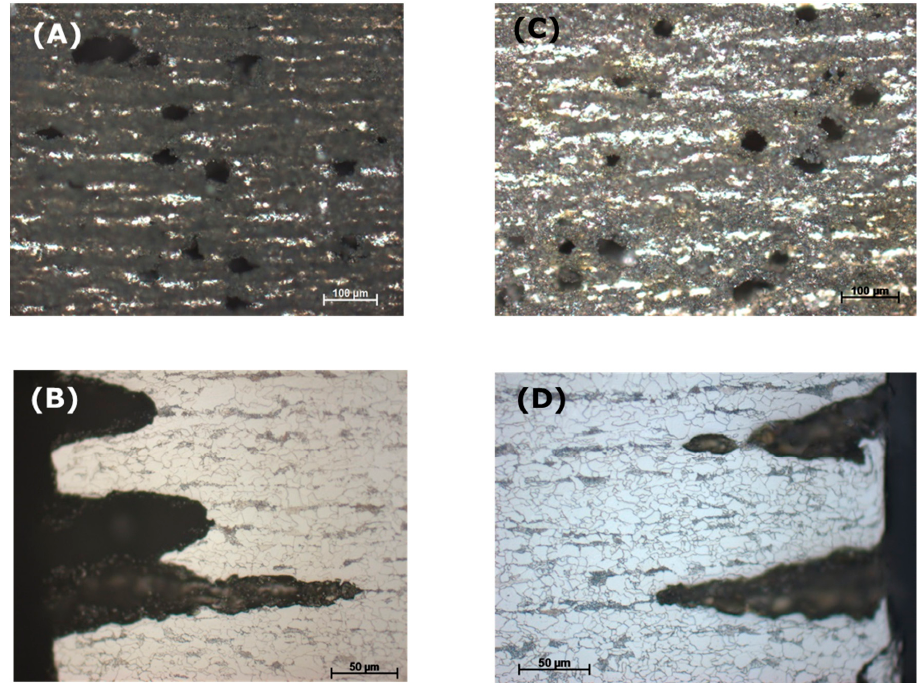
Figure 15. Effect of CO 2 flow rate on the pitting behavior of L360NB in condensate containing 0.0184 M HNO 3 and 0.114 M H 2 SO 4 . ( A , B ) 50–60 mL/min, and ( C , D ) 20–30 mL/min. ( B) and ( D) are the etched cross-section image of ( A ) and ( C ), respectively.